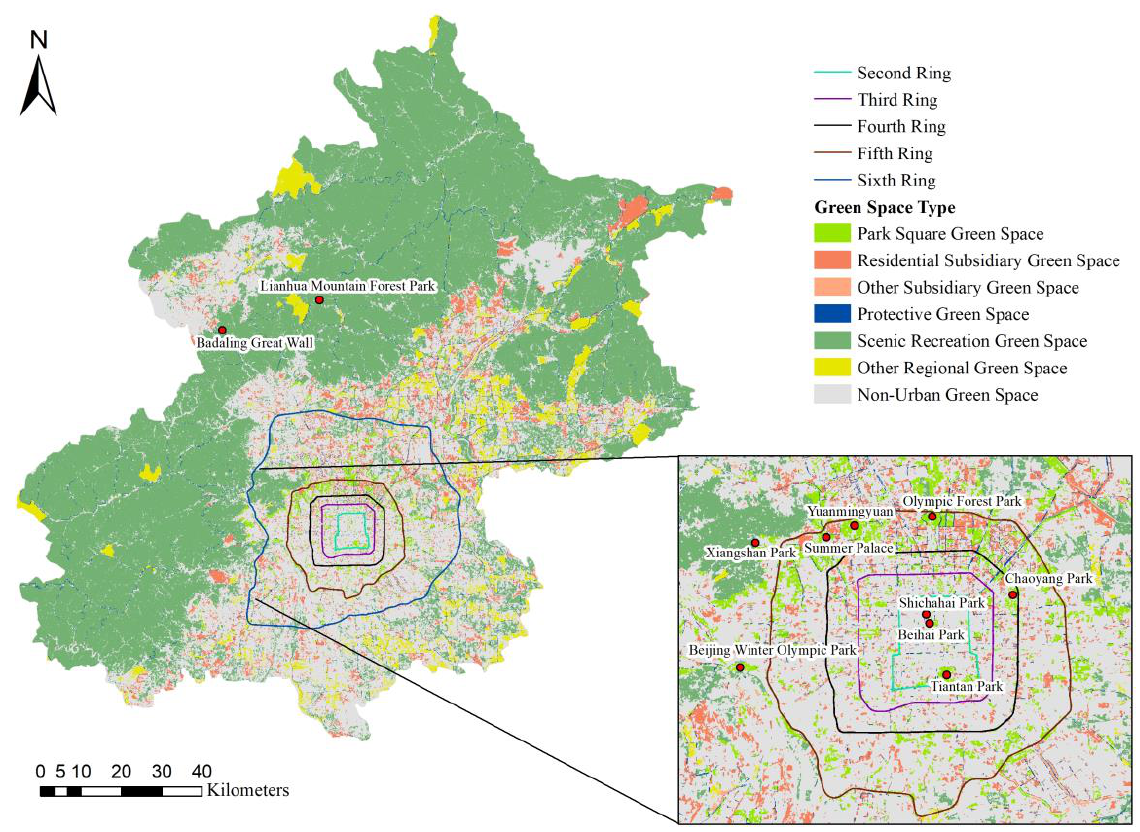
Figure 5. The distribution of six functional UGS in study area.